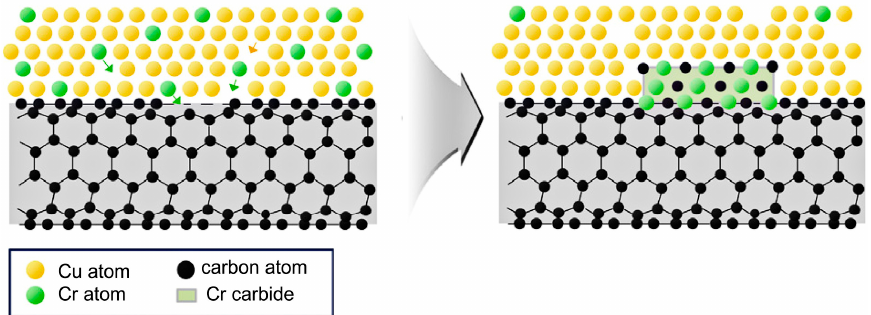
Figure 28. A schematic view of epitaxial growth of Cr carbide at the CNT/Cu-Cr interface via the substitutional diffusion of Cr atoms into the nanotubes during sintering [170]. (Reproduced with permission from [170], Elsevier, 2013.)